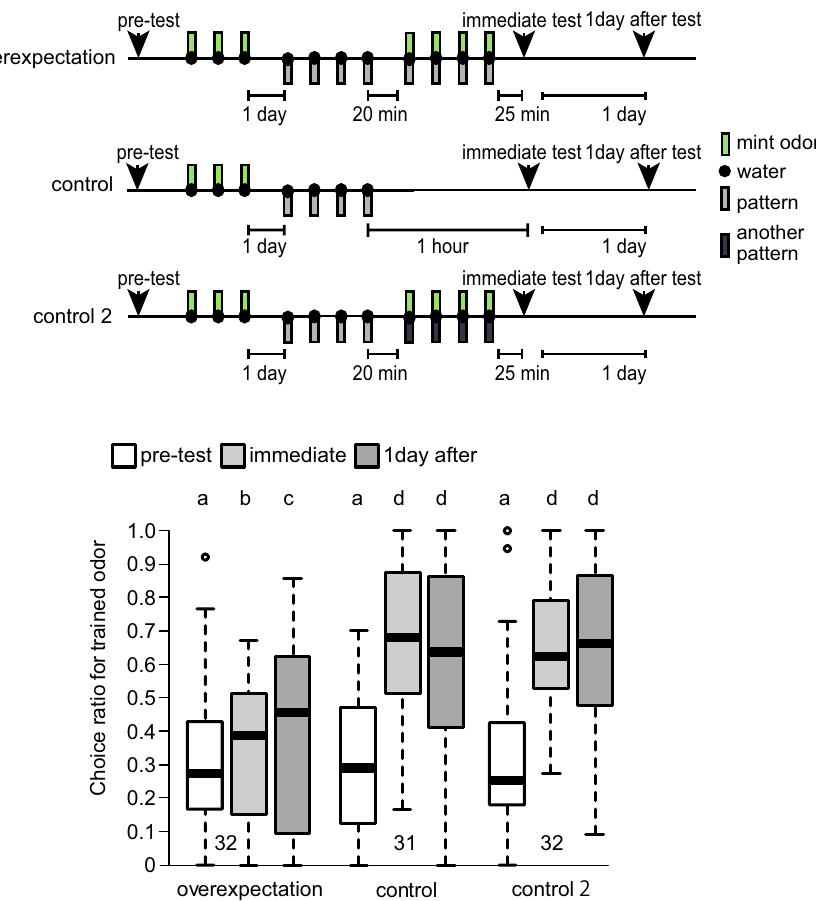
Figure 3. Results of Experiment 2: Effect of overexpectation lasts 1 day. Crickets in one group (overexpectation group, n = 32) were subjected to 3 conditioning trials in which mint odour was paired with water (O+ training). One day later, they were subjected to 4 conditioning trials in which a white-centre and black-surrounding pattern was paired with water (P+ training), and 20 min later, they were subjected to 4-trial pairing of an odour-pattern compound with water (OP+ training). Crickets in the control group (n = 31) were subjected to 3-trial O+ training and 1 day later they were subjected to 4-trial P+ training. The ITI was 5 min. Crickets in the control 2 group (n = 32) were subjected to 3 O+ training trials. After 1 day, they were subjected to 4 P+ training trials and then 4 pairings of a compound consisting of mint odour and black-centre and white-surrounding pattern followed by water (OP 2 + training). Relative odour preference was tested before training (pre-test), 1 h after completion of P+ training (immediate test), and 1 day after conditioning. The results in pre-test (white), immediate test (light grey) and 1 day after test (dark grey) are shown as box and whisker diagrams. The horizontal line in the box is the median and the box represents the 25–75 percentiles in this and in all following figures. Whiskers extend to extreme values as long as they are within a range of 1.5 * box length. The outliers are shown as open circles. A GLMM was used to examine relative preferences for the conditioned